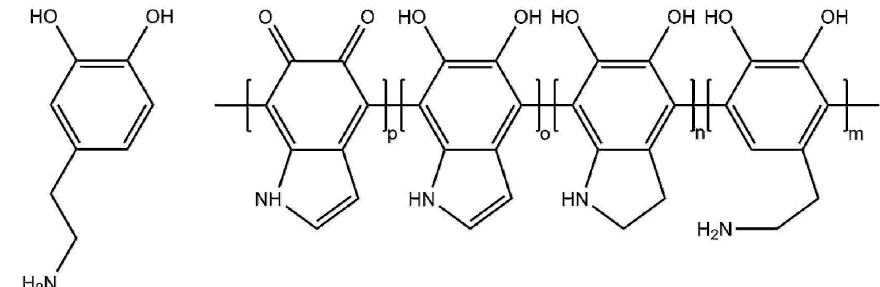
Figure 1. Proposed structure of a polydopamine chain consisting of covalently linked cyclized units containing indole, catechol, quinone, and amine groups [17,18].